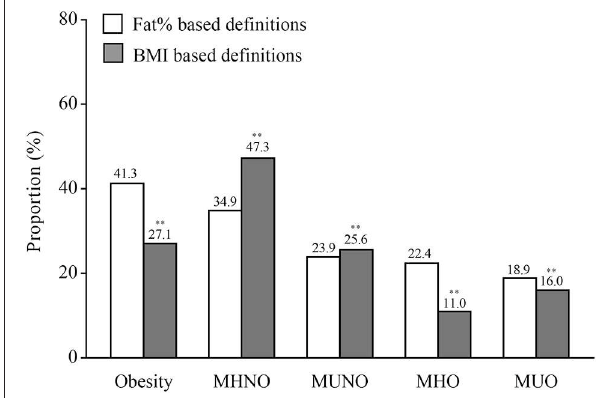
FIGURE 1 | The proportions of obesity and different metabolic phenotypes of obesity. In the graph, the column indicated to proportions. For the white columns, obesity was defined as fat% ≥ 25% for men and ≥ 30% for women. For the gray columns, obesity was defined as BMI ≥ 25kg/m 2 . ** P < 0.01 compared with the corresponding definition based on